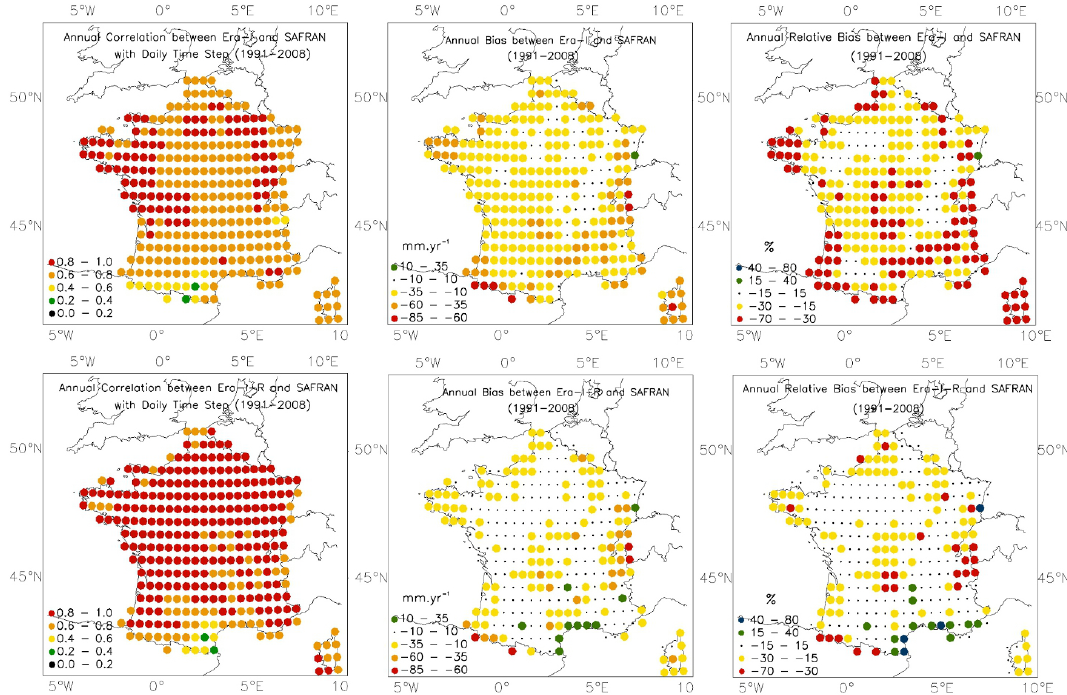
Fig. 5. Daily precipitation estimates over the 1991–2008 period: (top) ERA-I and (bottom) ERA-I-R vs. SAFRAN in terms of (left) temporal correlation ( R 2 ) , (centre) mean bias and (right) mean relative bias (mean bias/mean precipitation